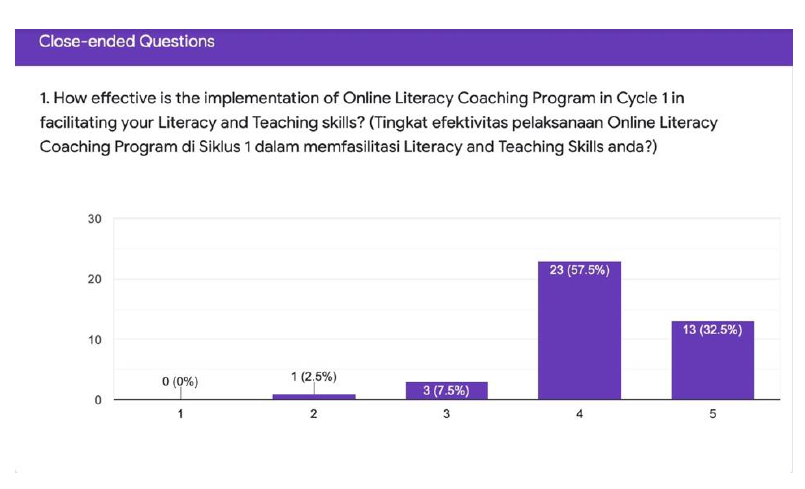
Figure 4: The Result of the Close-ended Questionnaire